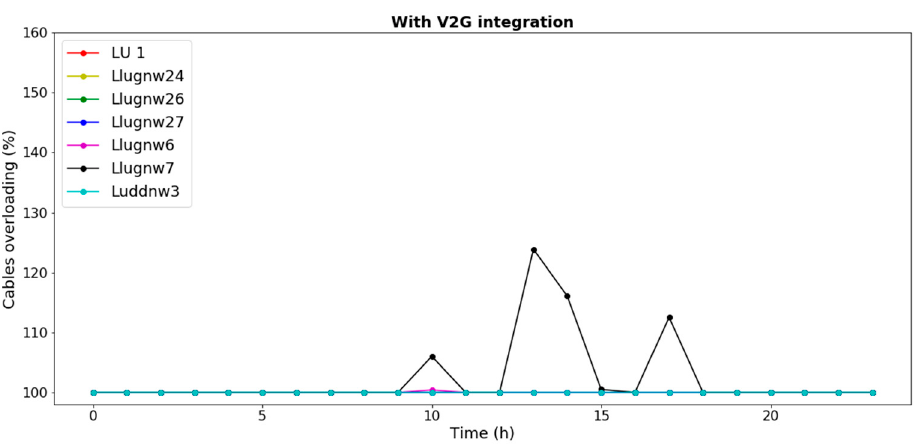
Figure 6. Cables overloading performance day before and after the integration of V2G.